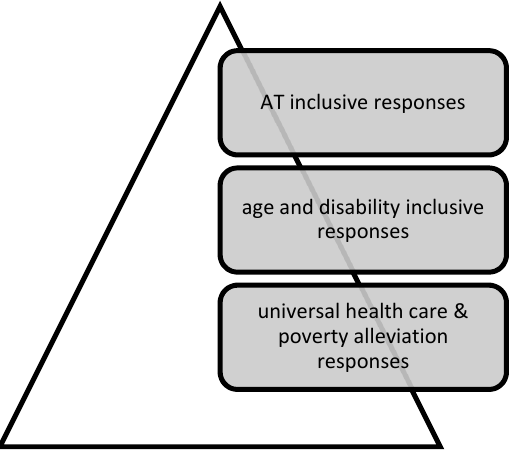
Figure 6. Multilevel actions required in a pandemic response.